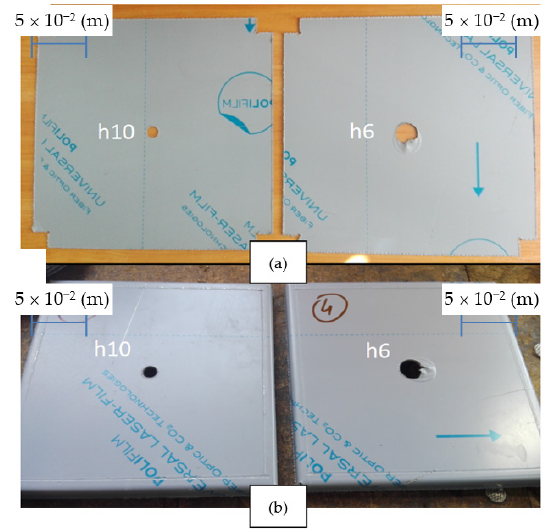
Figure 14. Example research samples (model h6 and model h10) for the flange extrusion process after laser cutting ( a ) and after bending the edges ( b ).